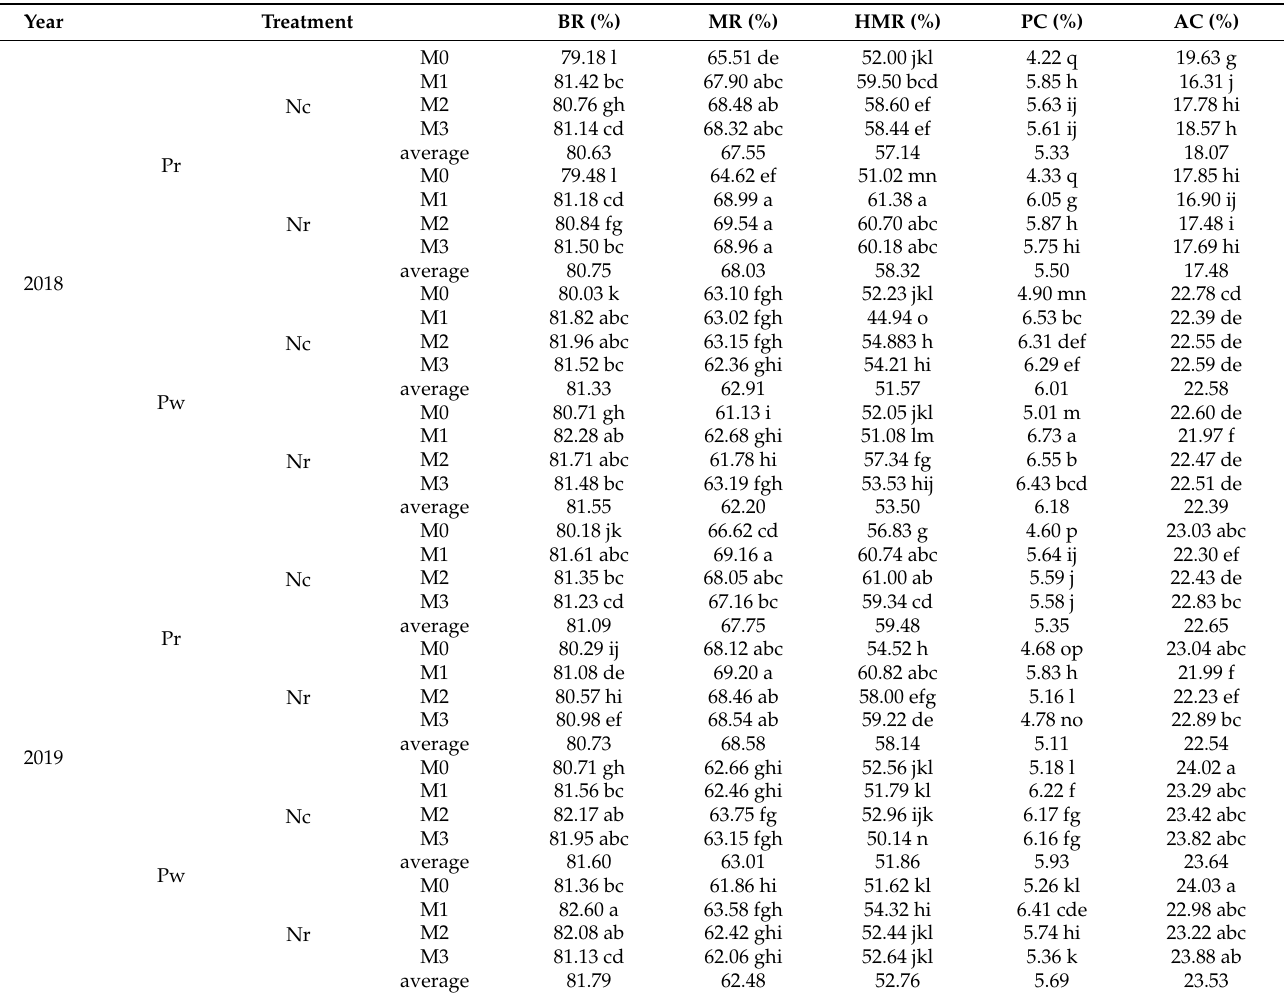
Table 3. The effects of the N application rate in the previous season and N management in the rice season on rice quality